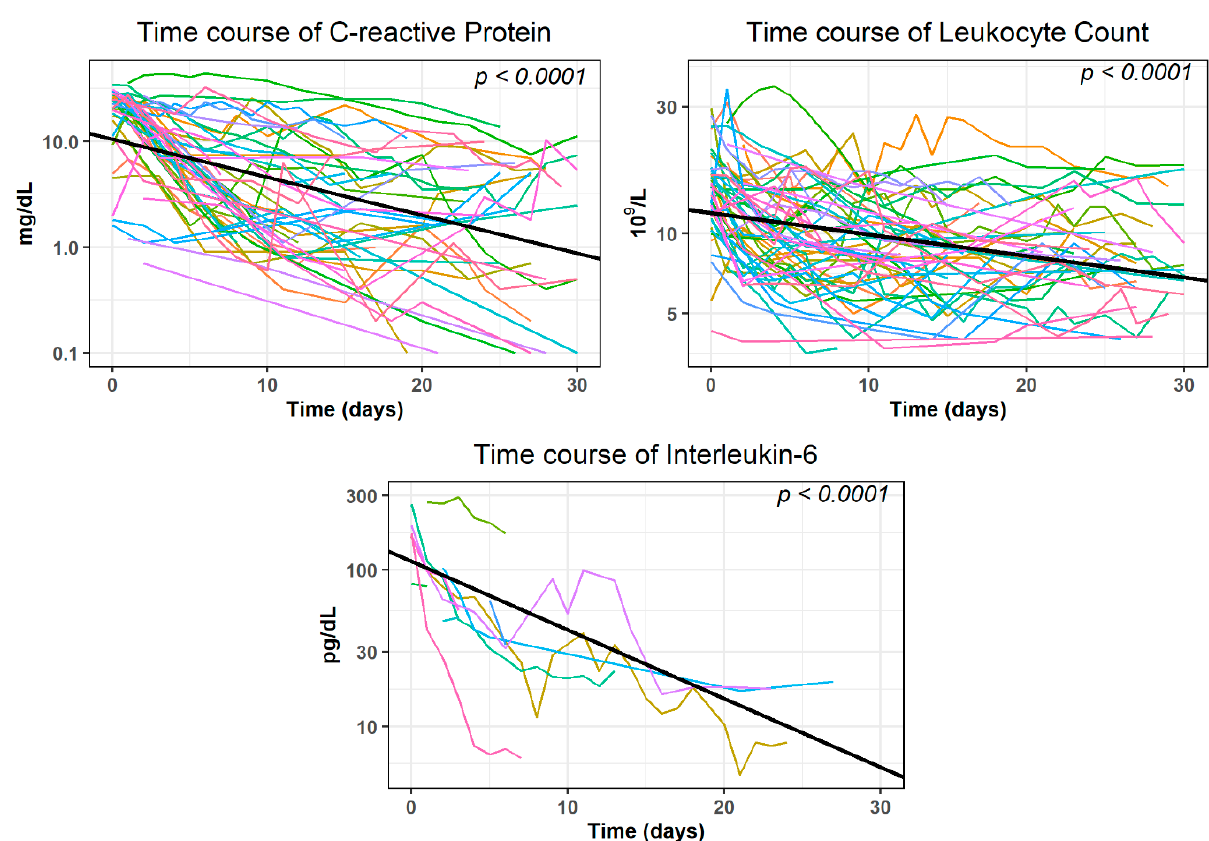
Figure 6. Time course of laboratory parameters within 30 days after the intervention. Subjects had no evidence of additional surgery or complications in their patient records.